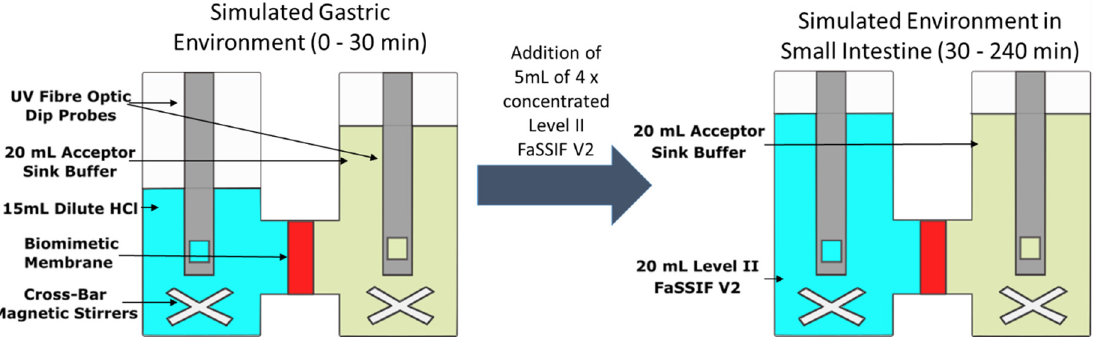
Figure 2. Schematic of the dissolution-permeation (D-P) test using the µ FLUX apparatus